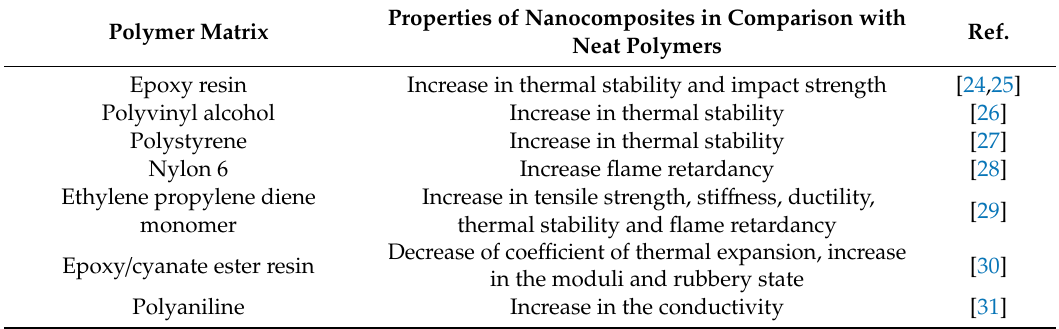
Table 2. Overview of HNTs / polymer